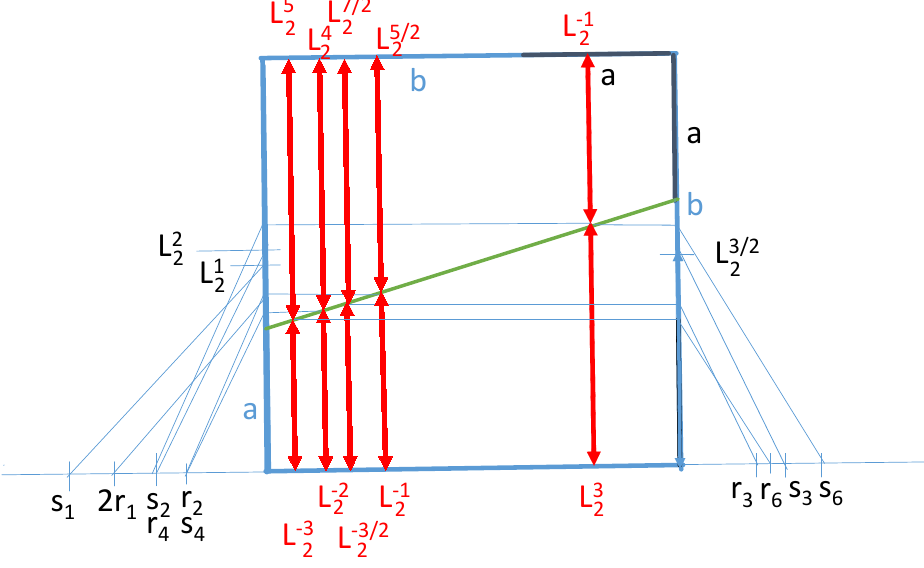
Figure 13: Lehmer means constructed in the bisymmetric crossed ladders diagram. Figure 13. Lehmer means constructed in the bisymmetric crossed ladders diagram.